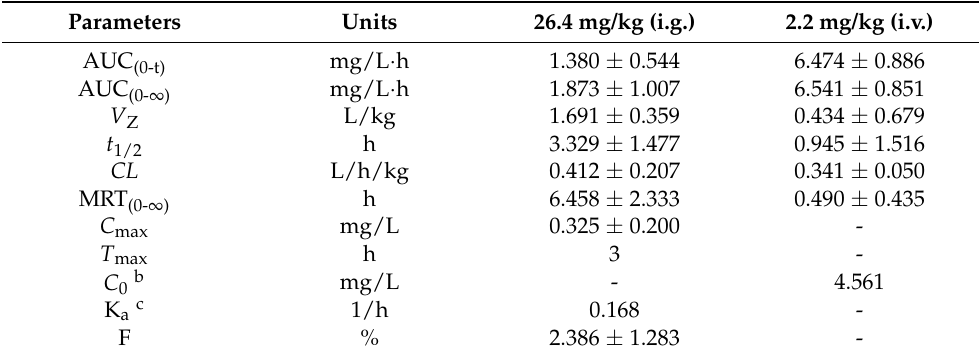
Table 2. Main pharmacokinetic parameters of azalomycin F 4a after intragastric administration